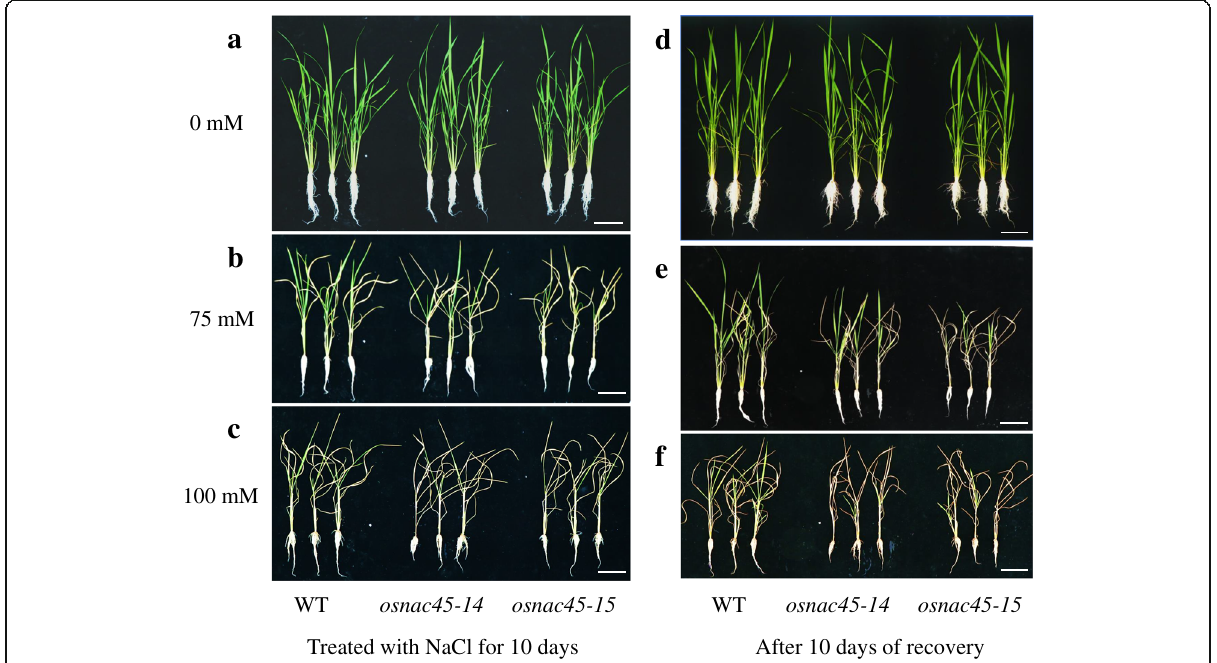
Fig. 5 Loss of OsNAC45 decreases salt tolerance in rice. Performance of Nipponbare and osnac45 lines treated with 0 mM ( a ), 75 mM ( b ), 100 mM or ( c ) NaCl for 10 days. Performance of Nipponbare and osnac45 lines that were allowed to recover for 10 days after the 10-day treatment with 0